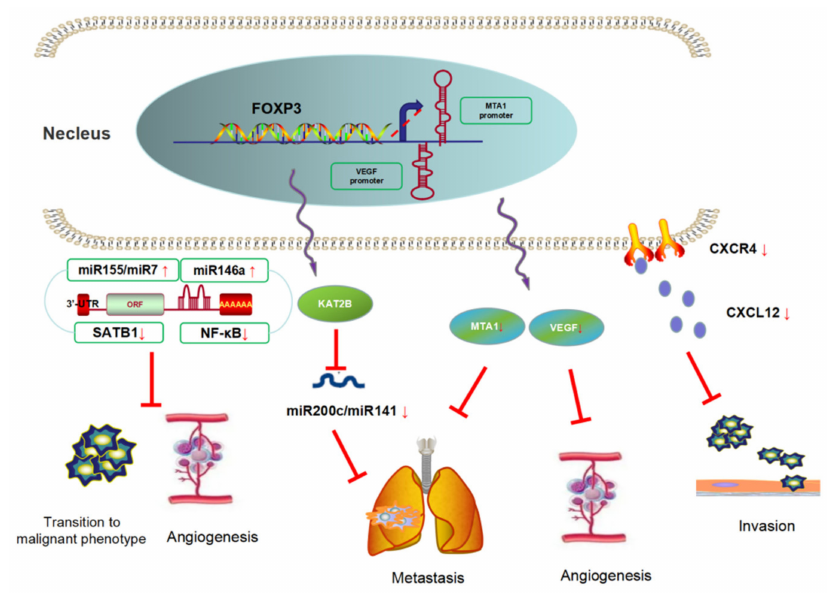
Figure 4. FOXP3 is a suppressor of breast cancer metastasis. FOXP3 could inhibit BC metastasis using three approaches, namely contains angiogenesis genes suppression, chemokines secretion inhibition, and miRNAs negative-feedback loop